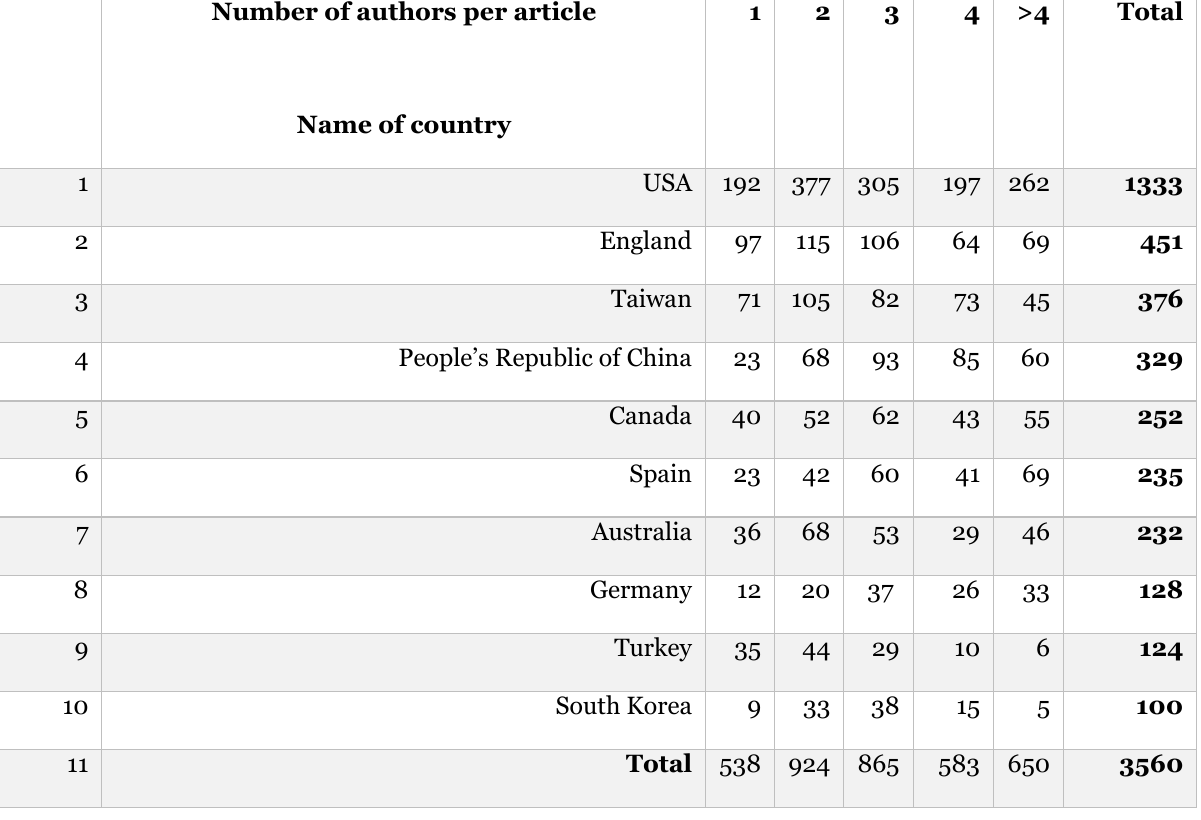
According to Table 3, scholars in the United States, with the highest production in the field of e-learning, have a tendency to write articles with two authors. Table 3 clearly demonstrates that writers prefer to work in teams of two or three members.